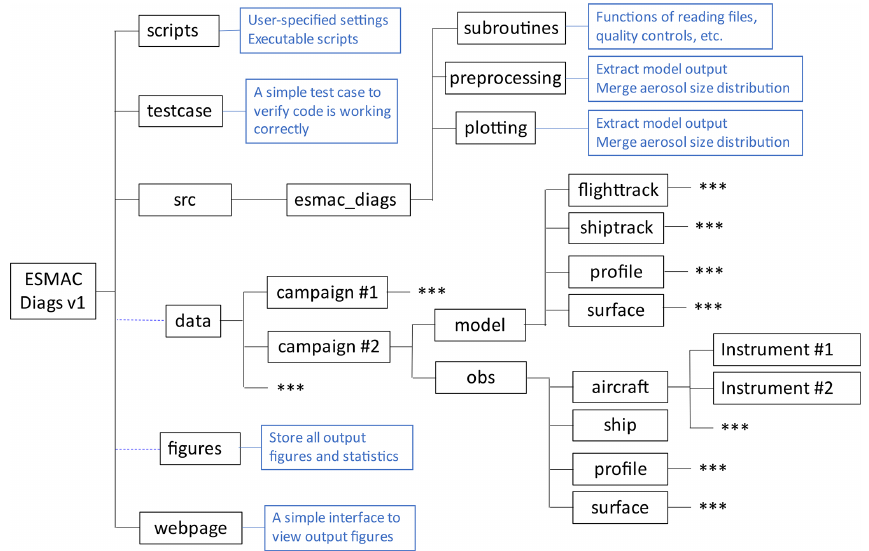
Figure 2. Structure of ESMAC Diags. The “scripts” directory contains executable scripts and user-specified settings. The “src” directory contains all source code, including code used to preprocess model output, read files, merge measurements from different instruments, compute observed versus simulated statistical relationships, and plot results. All observational and model data in the “data” directory are organized by field campaign. The diagnostic plots and statistics are put in the “figures” directory, also organized by field campaign. The “testcase” directory includes a small amount of input and verification data to test if the package is installed properly. The “webpage” directory provides an interface to view diagnostics figures. Boxes in blue describe the functions of the directory. Asterisks represent boxes that follow the same format as those shown in